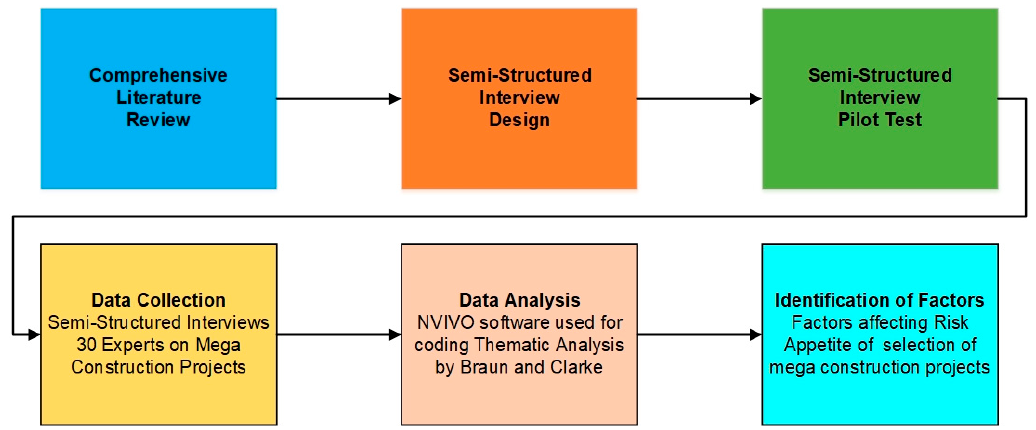
Figure 5. Flow chart of the research methodology.